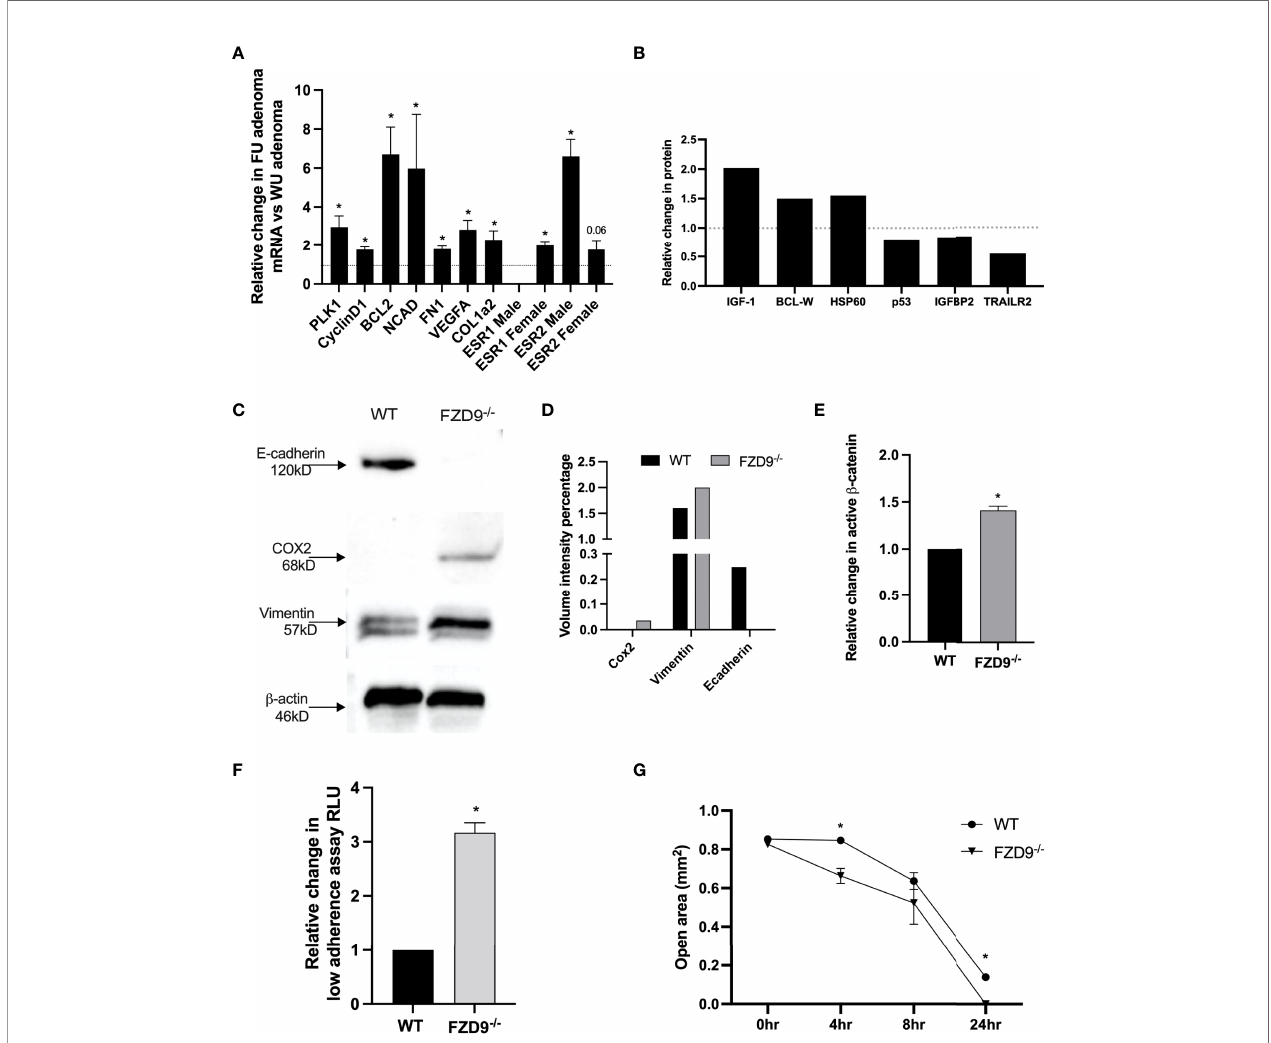
FIGURE 5 | Urethane induced FZD9 -/- adenomas have a more tumor-like phenotype. (A) Change in gene expression in FZD9 -/- (FU) adenomas relative to wild type (WU) adenomas, measured by qPCR. Data is normalized to RPS18 and assays were conducted in triplicate. (B) Changes in apoptosis pathway proteins was measured by dot blot, normalized to dot blot positive controls, and quanti fi ed. (n=1) (C) Change in protein expression measured by western blot of FZD9 -/- and WT adenoma cell lines. b - actin is a loading control. (D) Quanti fi cation of bands from western blot in (C) . (E) Active b -catenin was measured by ELISA in a Fzd9 -/- adenoma cell line and is shown relative to a WT adenoma cell line. The assay was conducted in triplicate. (F) Growth on low adherence plates measured by fl uorescence viability assay in a FZD9 -/- adenoma cell line and shown relative to a WT adenoma cell line. Assay was conducted in triplicate. (G) Migration was measured in triplicate by quantifying the open area left by a silicone insert in cells cultured over 24 hours. WT, wild type tumor cell line; F9 -/- , FZD9 knockout tumor cell line. Statistical signi fi cance was measured by a two-tailed t-test and